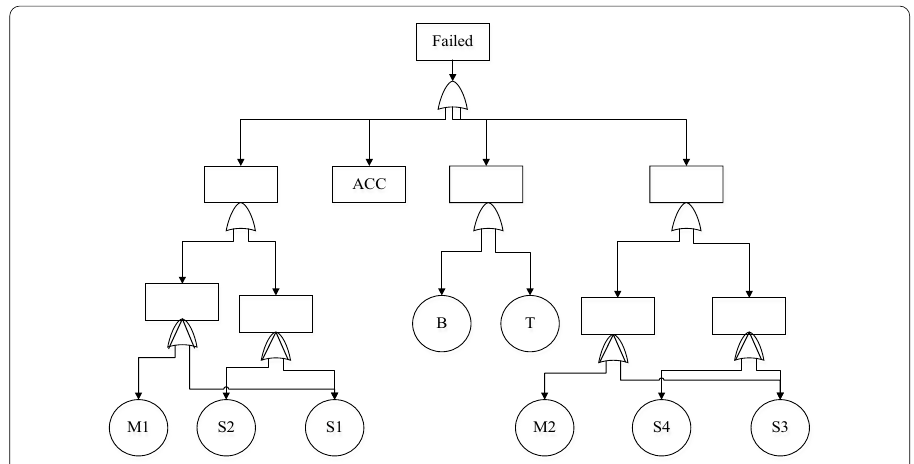
Fig. 18 Pandora TFT of ACC system